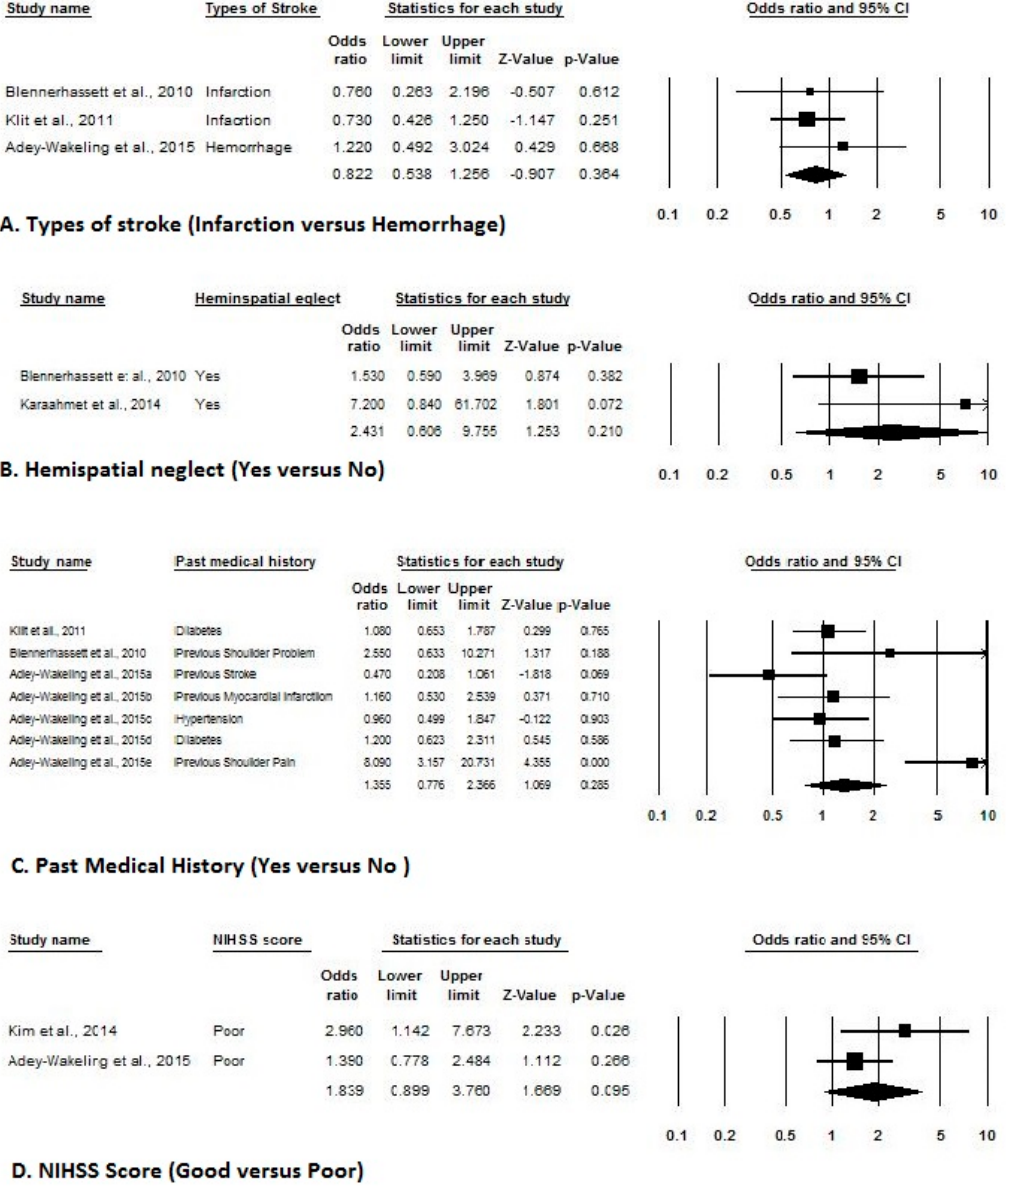
Figure 5. Clinical risk factors for shoulder pain after stroke (( A ). Types of stroke, ( B ). Hemispatial neglect, ( C ). Past medical history, ( D ). National Institutes of Health Stroke Scale-NIHSS Score).